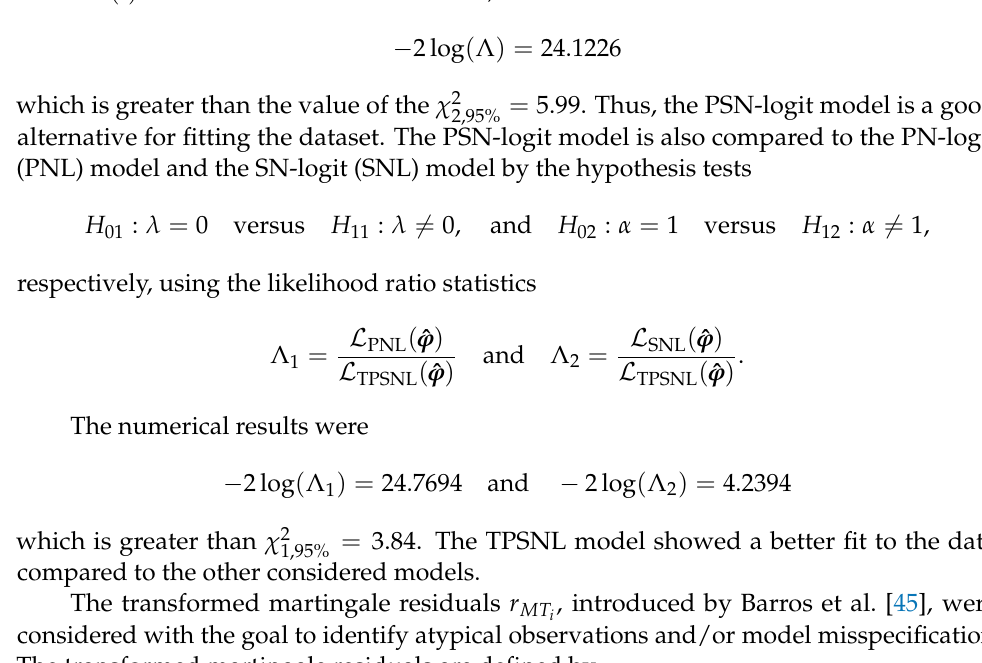
: ( a ) SN-logit model, ( b ) PSN-logit, and ( c ) i